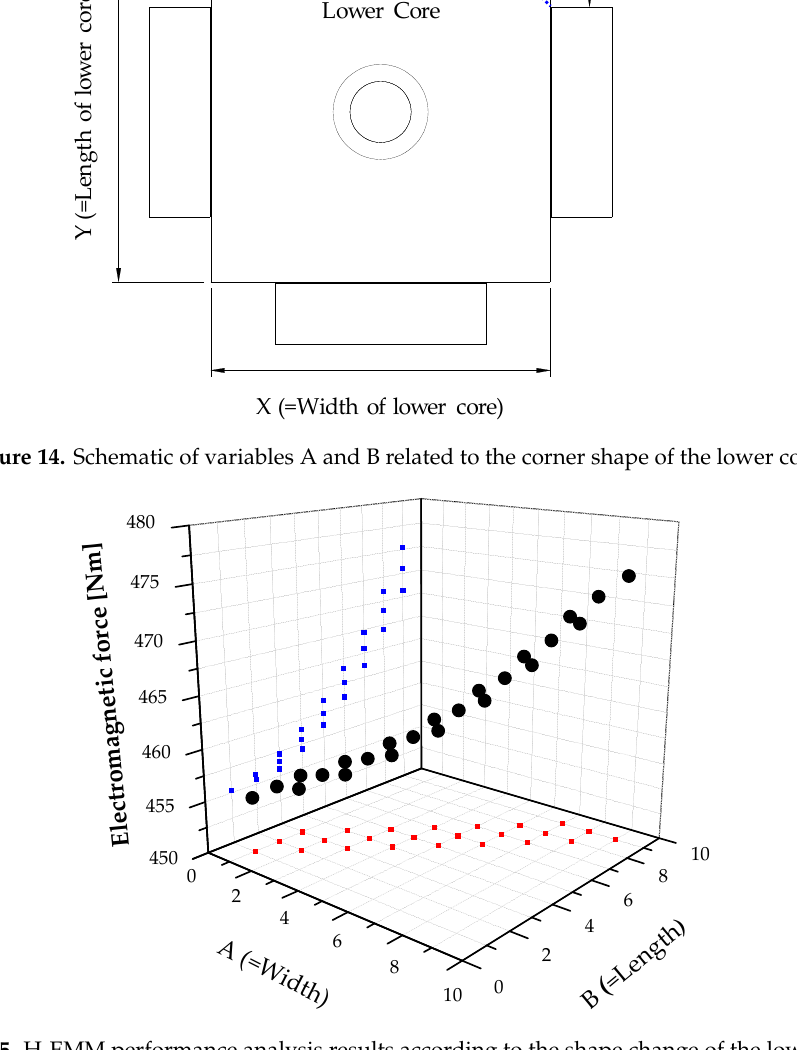
Figure 15. H-EMM performance analysis results according to the shape change of the lower core.